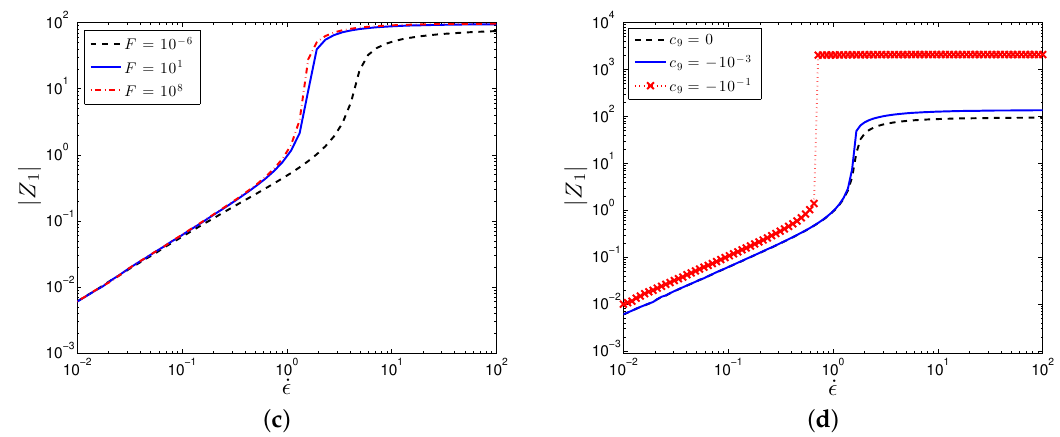
Figure 6. Plot of the first normal structure difference, Z 1 , against extension rate for varying values of ( a ) c 8 , ( b ) S , ( c ) F , and ( d ) c 9 . Parameter values are: S = 10 − 1 , F = 10, c 3 = − 23.5, c 7 = − 0.47, c 8 = 10 − 4 , c 9 = 0, η S = 1, f ( φ ) = 1.0957, k 1 = − 10 3 , k 4 = −